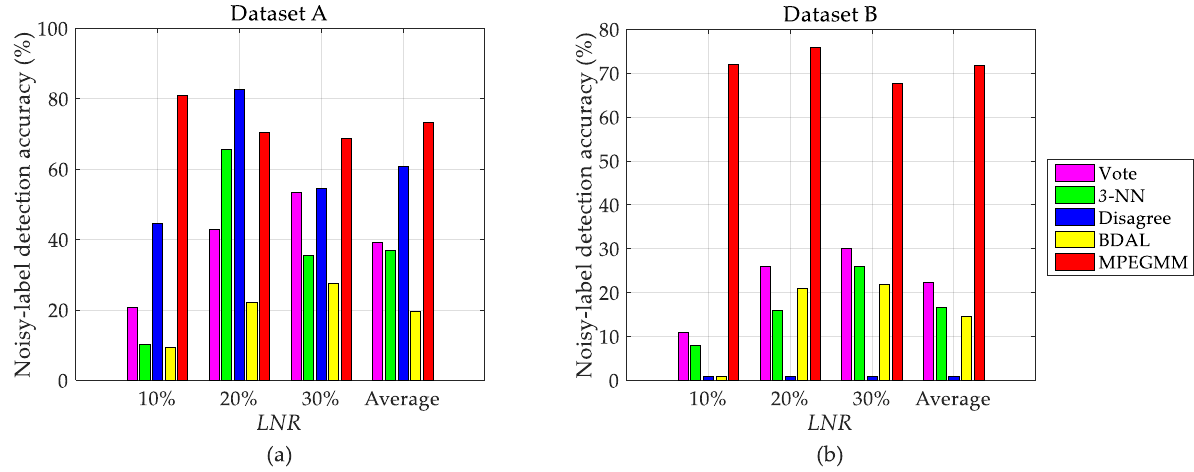
Figure 7. Noisy-label detection accuracy with LNR under setting 1. ( a ) Detection accuracy on dataset A; ( b ) detection accuracy on dataset B.